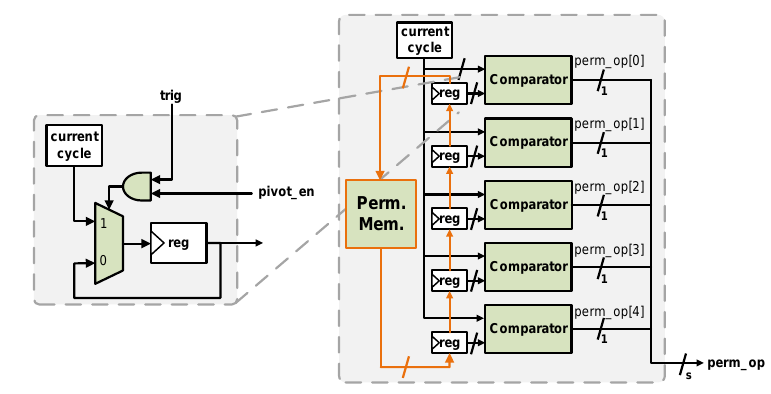
Figure 10: Logic to deal with operation swap ( s = 5). (Orange color indicates components used only for SPEA and DPEA see Section